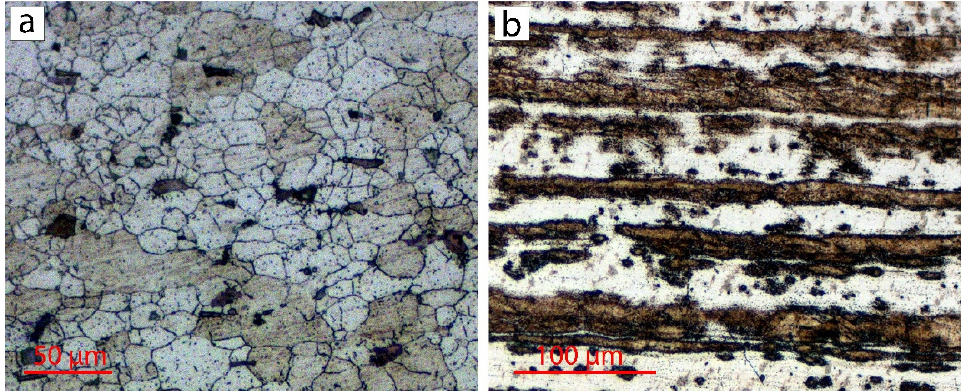
Figure 1. Initial microstructure of AA2024-T3 plate ( a ) and AISI304 plate ( b ). Table 2. Thermal properties of used materials.